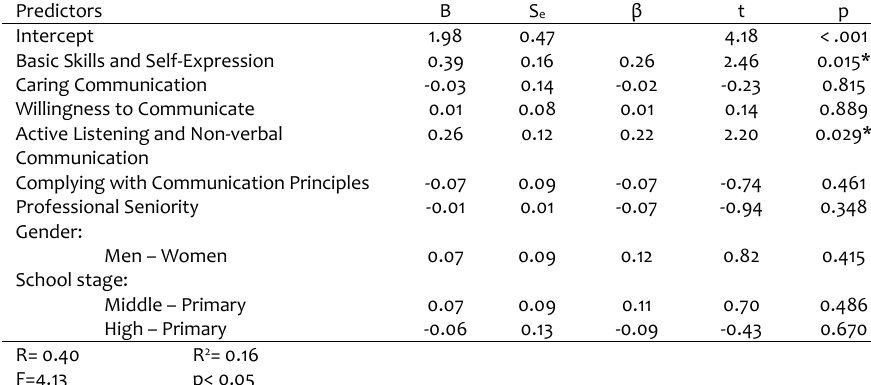
Table 4. Multiple linear regression analysis results for teachers’ level of Authoritative CMS